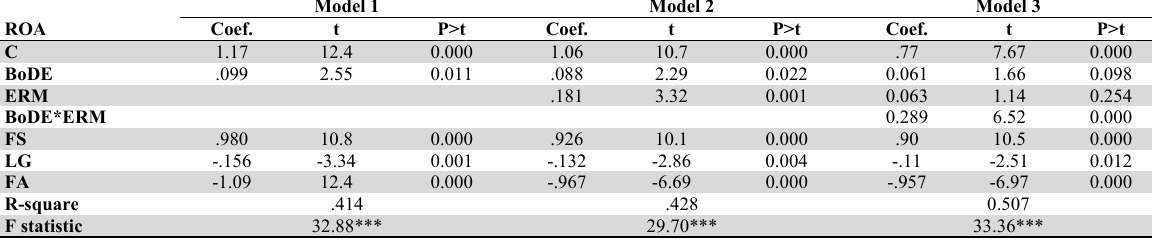
Results of the moderating effect of ERM between BoDE and ROA Model 1 Model 2